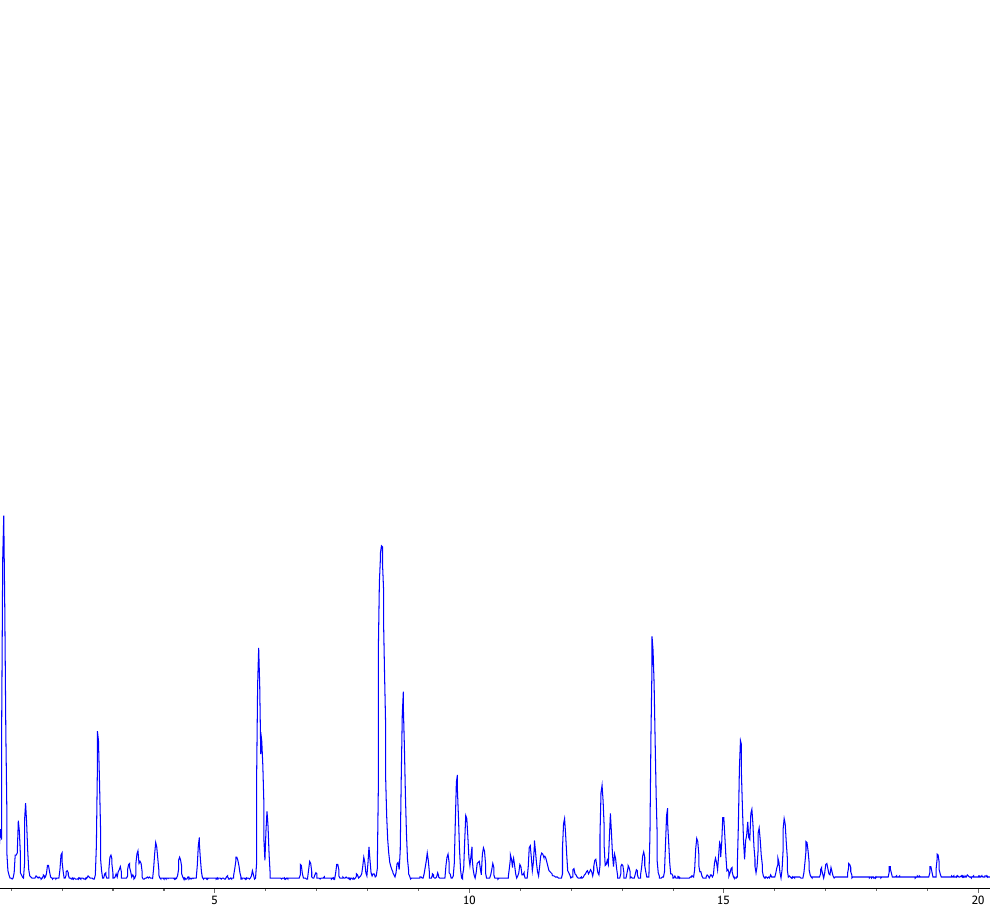
Figure A8. Ilex × meserveae ‘Blue Angel’, basic peak chromatogram, negative mode.